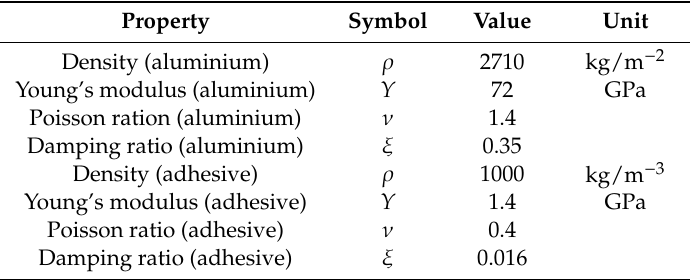
Table 2. Property parameters of the aluminum plate and bonding layer.